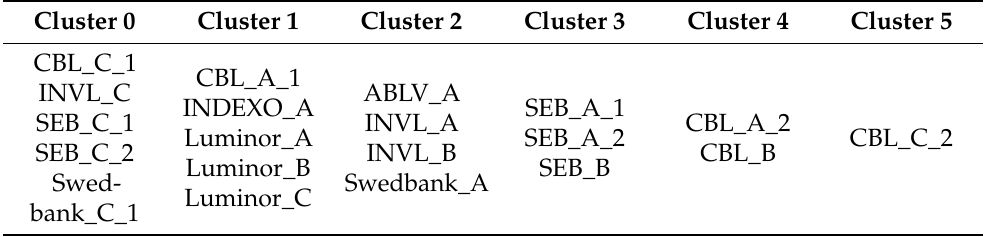
Figure A3. Top 50 best K-means algorithm results based on silhouette score using a different number of clusters. The cluster value is noted in the parentheses, and most often occurring combinations are visualized. Table A4. Top 100 best affinity propagation algorithm results based on silhouette score using different parameters that result in a different number of clusters. The table shows the composition of often occurring cluster combinations when six clusters were used.